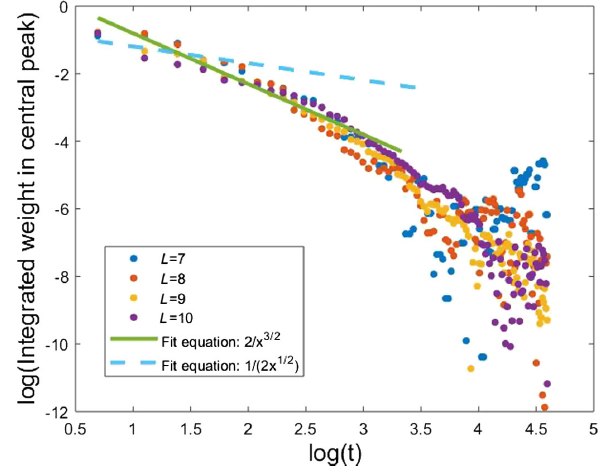
FIG. 4. Log-log plot of the area under the central fracton peak as a function of time. Data correspond to the operator right weight on the central site (cid:3) one site and are averaged over ten runs. The green line corresponds to a fit to the anomalous decay exponent of 3 = 2 reported in our original paper. The dashed blue line is a fit to the conventional (not anomalous) exponent of 1 = 2 , for the sake of comparison. Data for L ¼ 7 ; 8 ; 9 ; 10 with the charge initially on a middle site. The linear fit remains valid only over an intermediate range of times, after which finite-size effects become